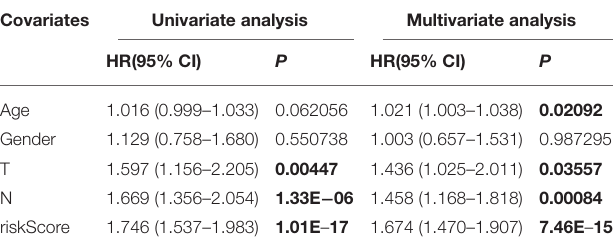
TABLE 1 | Univariate and multivariate Cox regression analysis of the training set. Covariates Univariate analysis Multivariate analysis